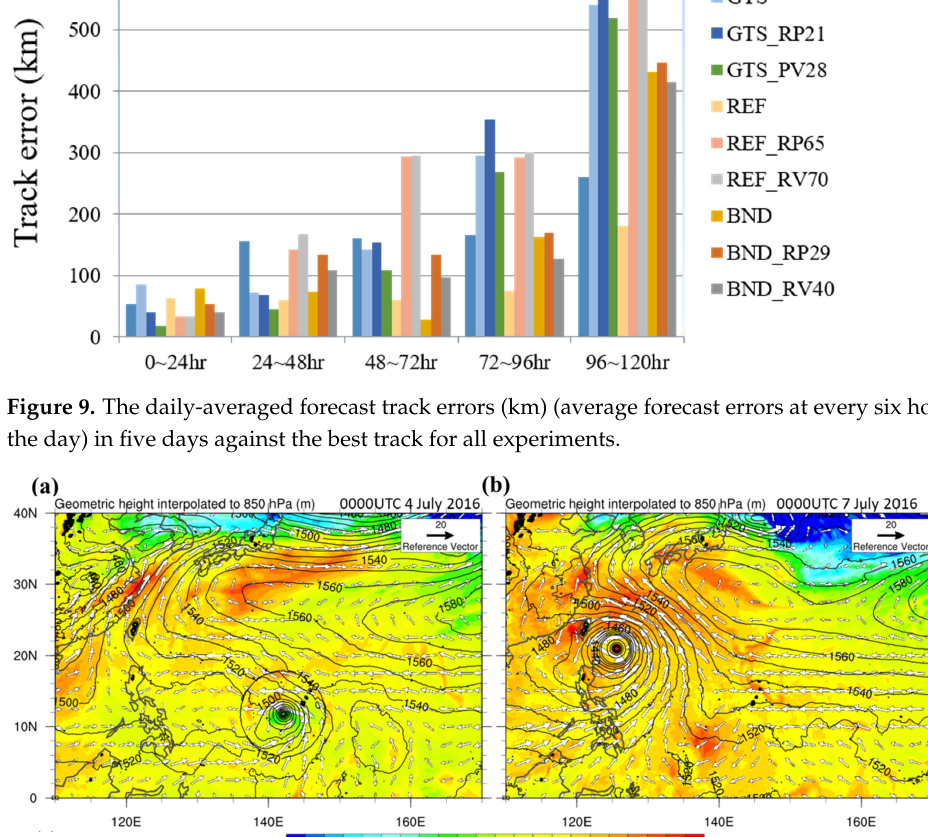
Figure 9. The daily-averaged forecast track errors (km) (average forecast errors at every six hours in the day) in five days against the best track for all experiments.